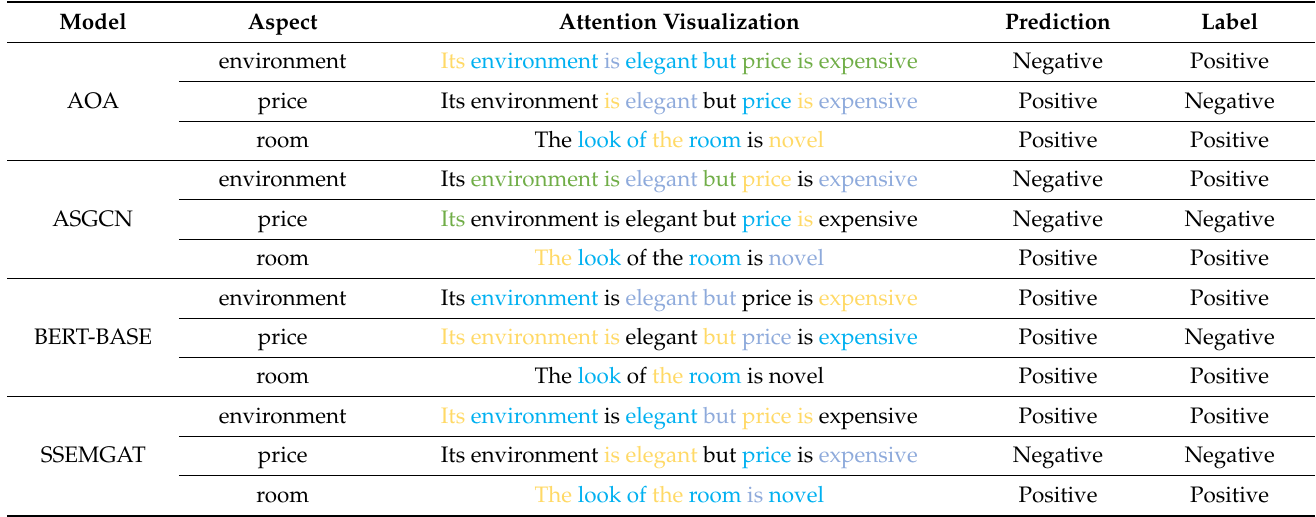
Table 6. Visual analysis of attention in review